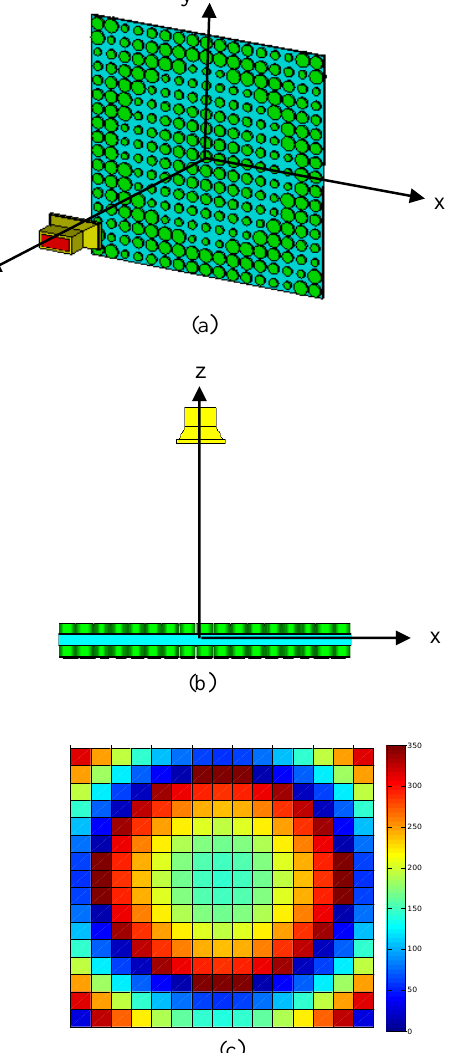
Figure 15 (a) The detailed structure of the NDRA transmitarray with silver supporting plane, (b) side view, (c) The phase shift distribution of the NDRA transmitarray with the silver supporting